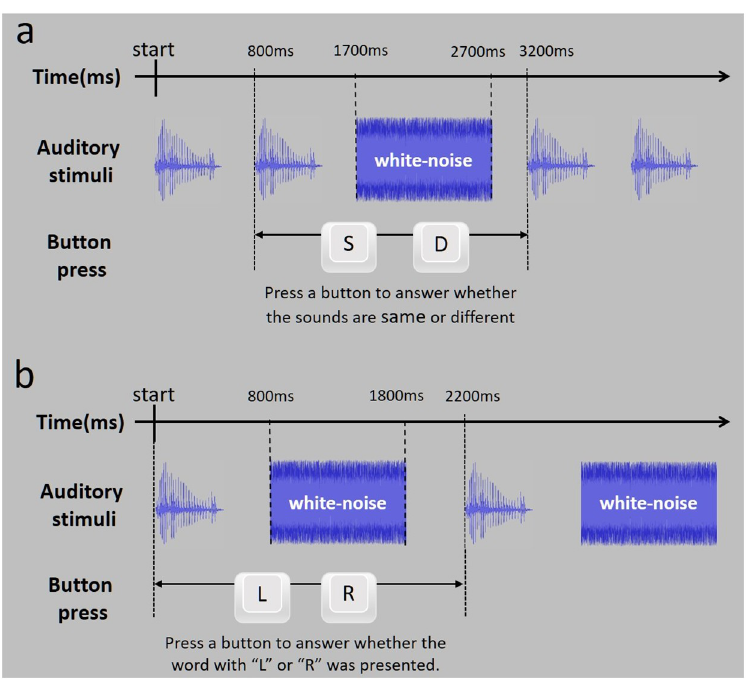
Fig 2. Task design of behavioral auditory tests; (a) trial sequence in discrimination task; (b) trial sequence in recognition test; ms milliseconds, R right, L left, S same, D